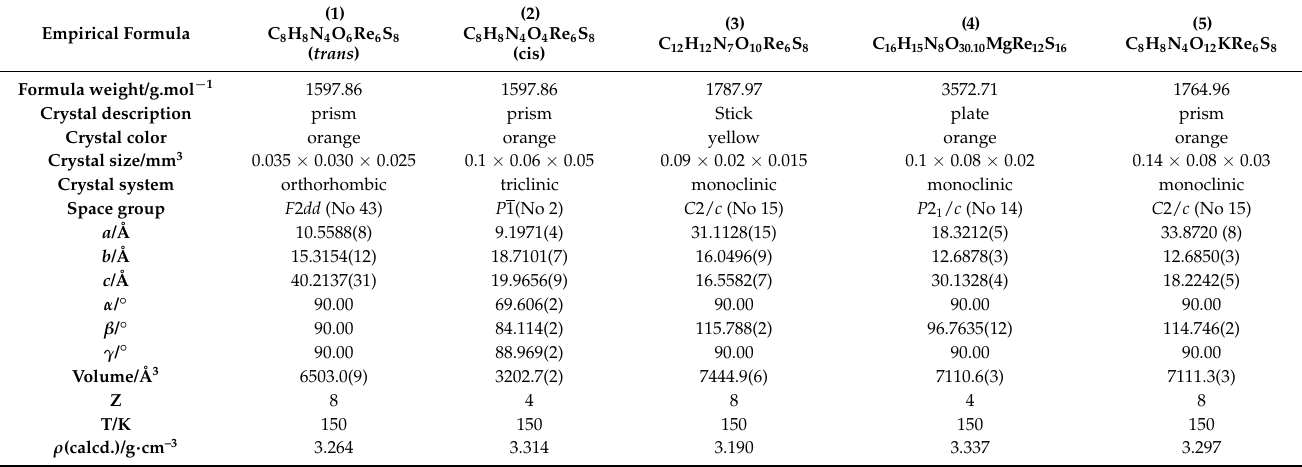
Table 1. Crystal data and structure refinement parameters for 1 – 5